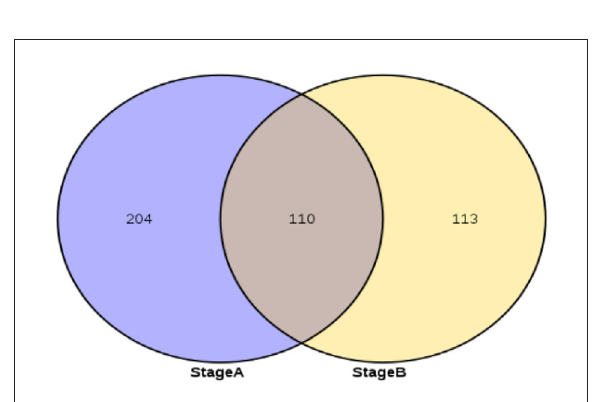
FIGURE2 circRNAs associated with secondary hair follicle morphogenesis and